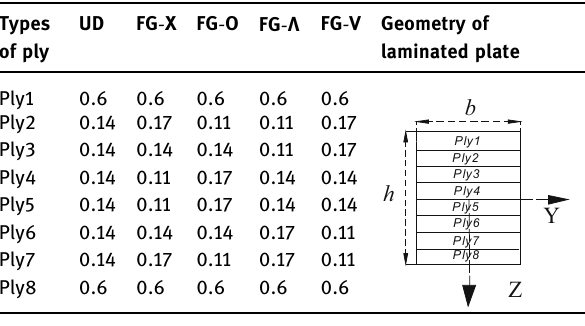
Table 3: Con fi guration of CNT for FRC/CNTRC laminate plate Types